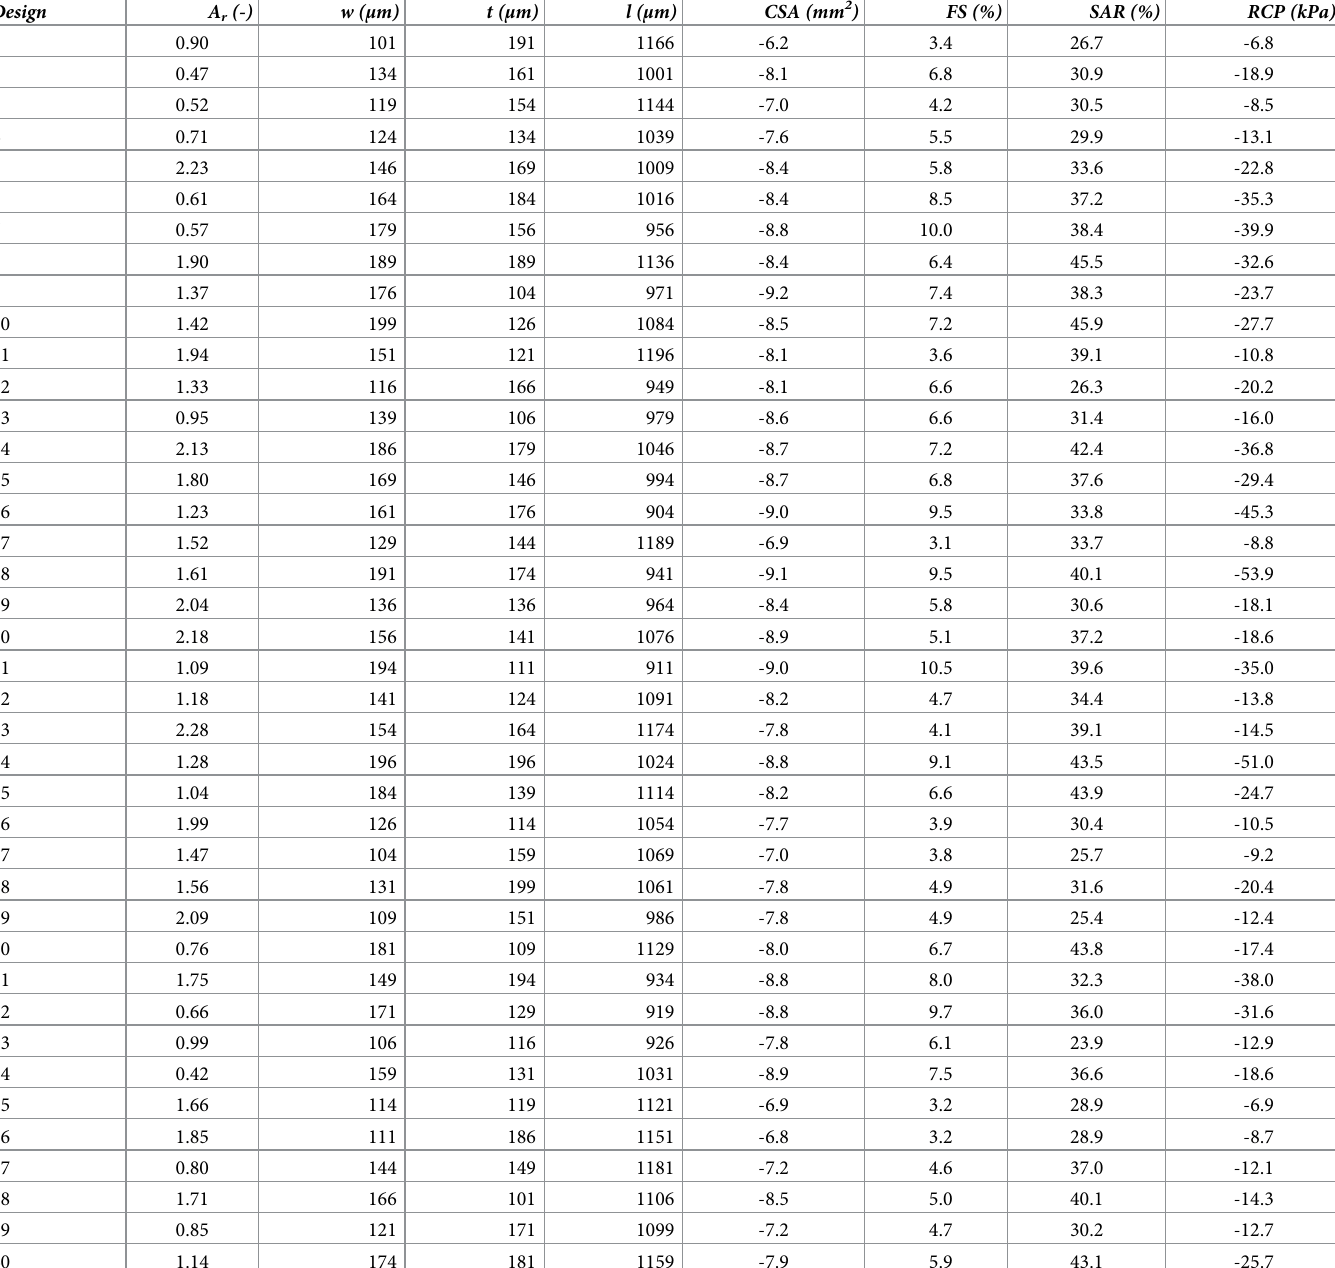
Table 4. Design parameters ( A r , w , t and l ) and respective performance metrics ( CSA , FS , SAR and RCP ) for each point considered under the optimised Latin hyper- cube sampling plan.